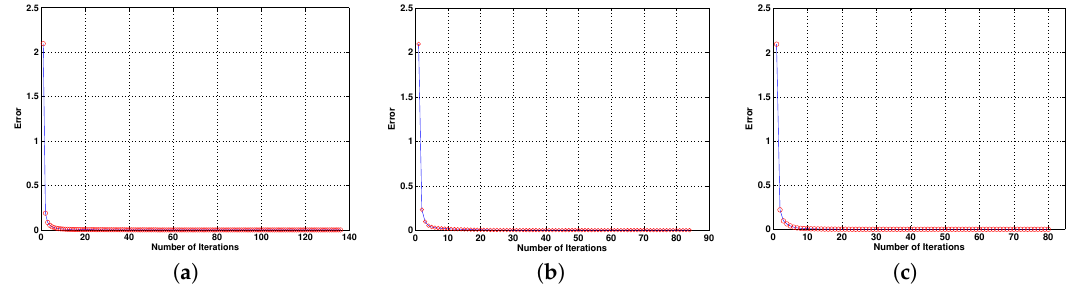
Figure 12. Convergence rate of discrete surface Ricci flow applied to compute the optimal flat metric of networks, with step length 0.1 and error threshold 1 × 10 − 5 . ( a ) A reversed C-shaped network with 424 landmarks: the convergence time is 2 s. ( b ) A network with one hole and 283 landmarks: the convergence time is 1 s. ( c ) A network with two holes and 297 landmarks: the convergence time is 1